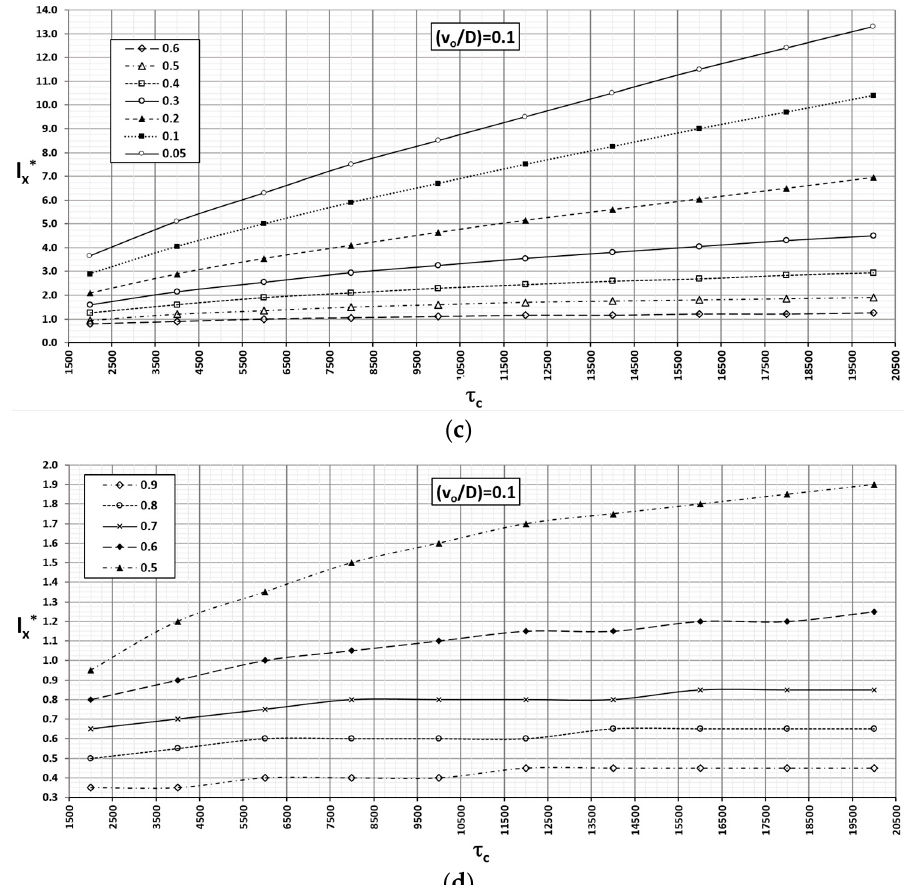
(cid:2932) (cid:3173) )∗ as a function of time factor τ = 0.1. v o =0.00006 m/d. ( a ) τ (cid:2913) as a function of time factor τ c . Parameter of the abacus v o = 0.1. v o = 0.00006 m/d. (cid:2913) . Parameter of the abacus (cid:2934)((cid:2913) (cid:4594) (cid:2888) x ( c (cid:48) ) D ∈ [10–100 days], ( c ) τ ∈ [2000–20,000 days], ( d ) τ ∈ [2000–20,000 days]. (cid:2913) (cid:2913) (cid:2913)